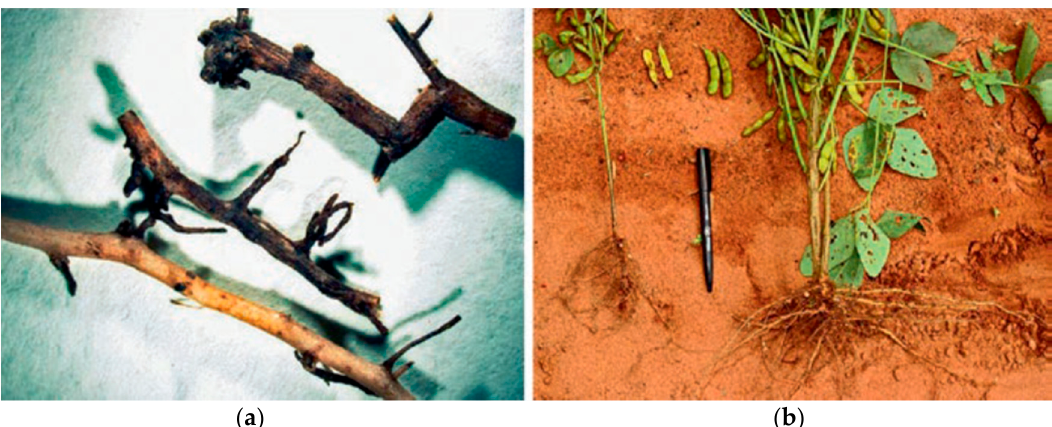
Figure 2. ( a ) Necrotic soybean roots infected with lesion nematodes, and ( b ) a stunted plant with a reduced and necrotic root system (green circle) compared to a noninfected plant (Photos: ( a ) Suria Bekker and ( b ) Driekie Fourie, North-West University, Potchefstroom, South Africa).